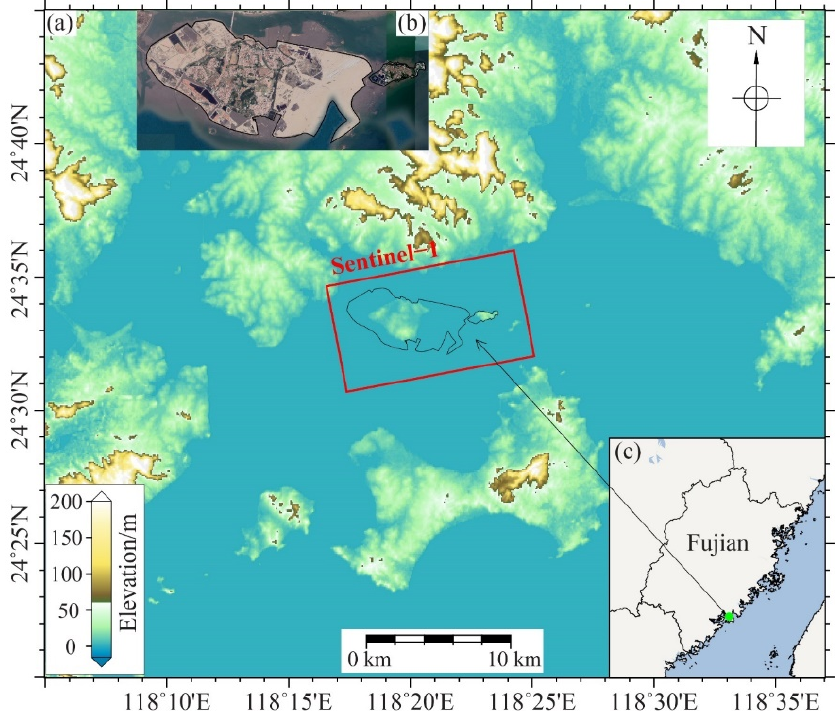
Figure 1. The Xiamen Xiang’an International Airport (XXIA): ( a ) coverage of Sentinel-1 images and the location of the XXIA; ( b ) optical image of Dadeng Island; ( c ) location of the XXIA in Fujian Province, China.